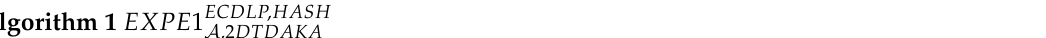
Algorithm 1 EXPE 1 ECDLP , HASH A ,2